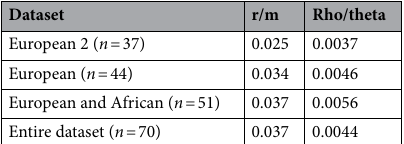
Table 3. Recombination metrics obtained through the Gubbins pipeline